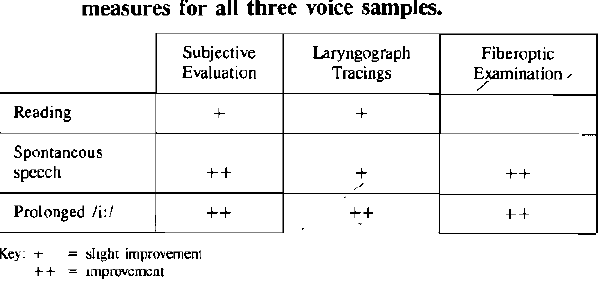
Key: -r = slight improvement + + =